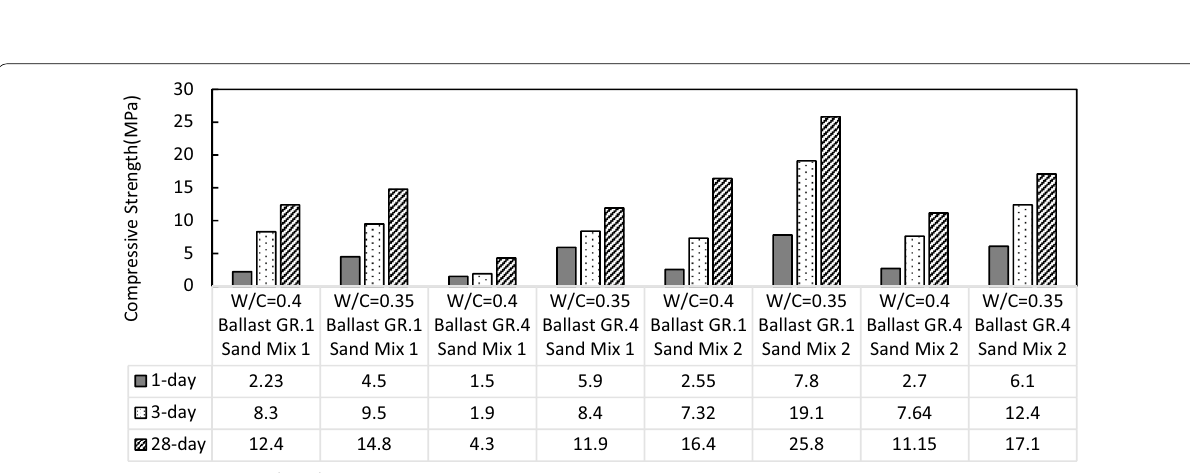
Fig. 13 PAC compressive strength at three ages.